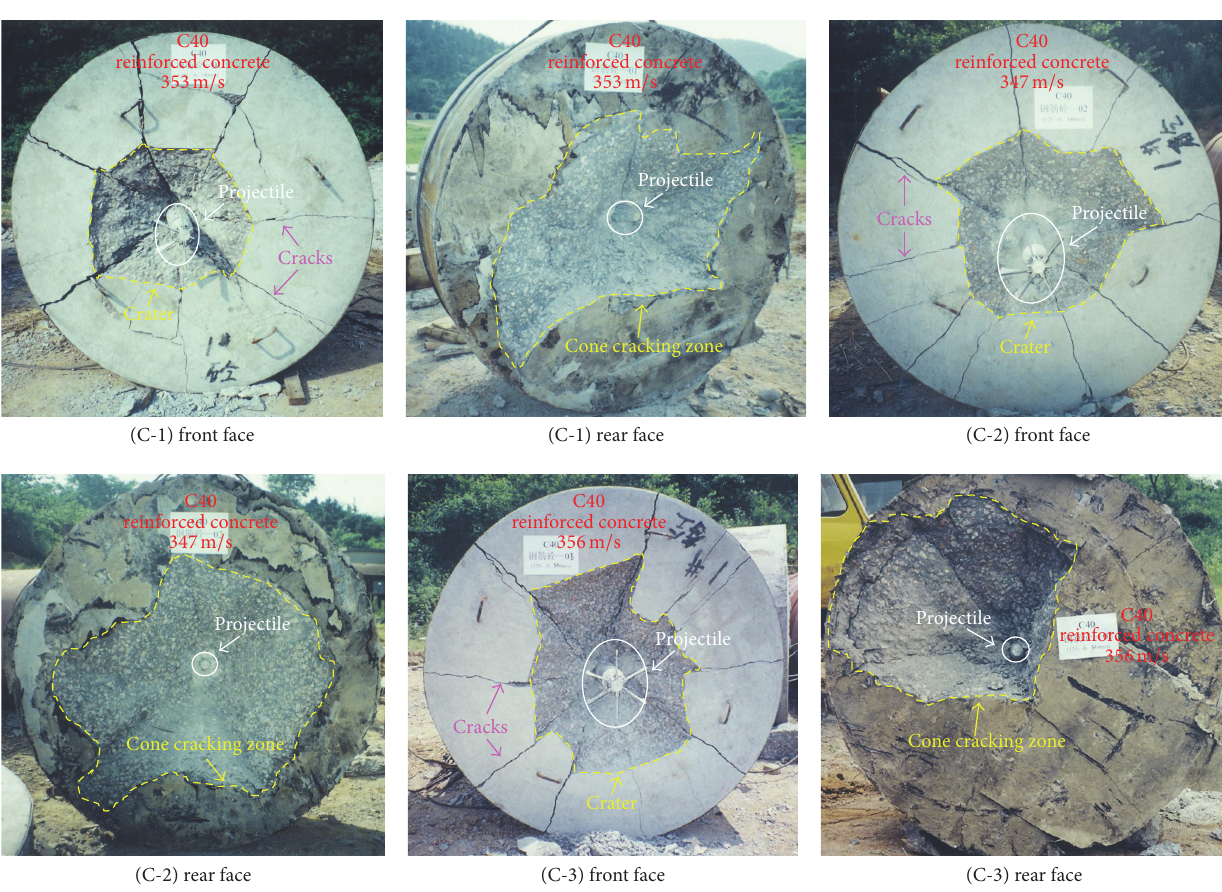
Figure 8: Damage of reinforced concrete.